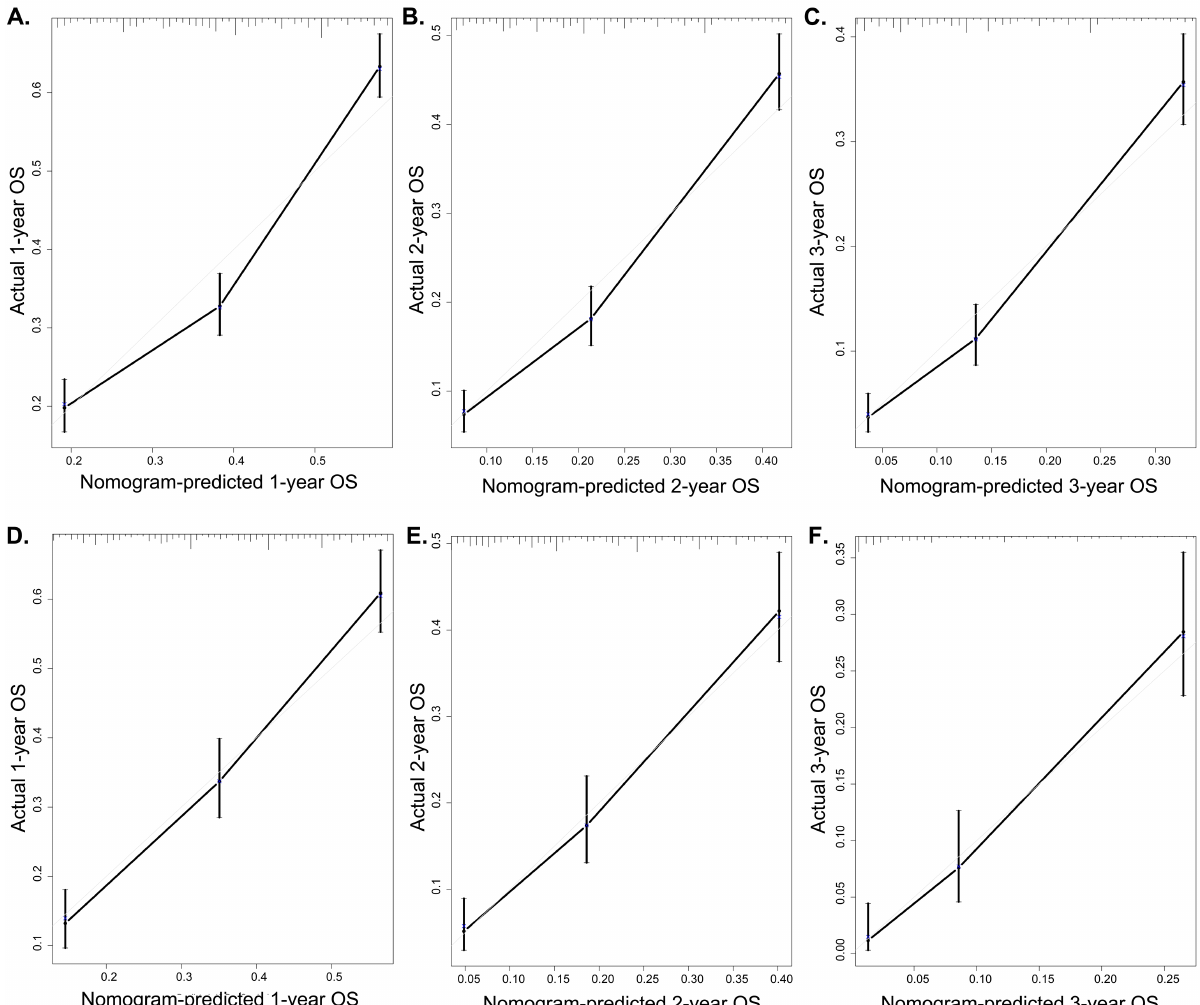
Figure 4 - Calibration plot of the 1-, 2-, and 3-year OS nomogram. The calibration curves of the 1-year (A), 2-yaer (B), and 3-year (C) nomogram model for OS in the primary cohort respectively; The calibration curves of the 1-year (D), 2-year (E), and 3-year (F) nomogram model for OS in the validation cohort